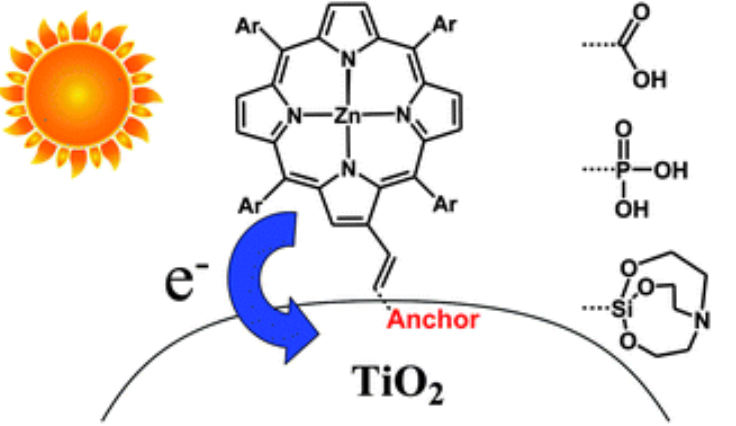
Figure 11. Structure of tetra-arylporphyrin dyes functionalized with three different anchoring groups (carboxylic acid, phosphonic acid and silatrane) for TiO 2 binding. Reproduced from reference [69] with permission from the Royal Society of Chemistry, copyright 2013.